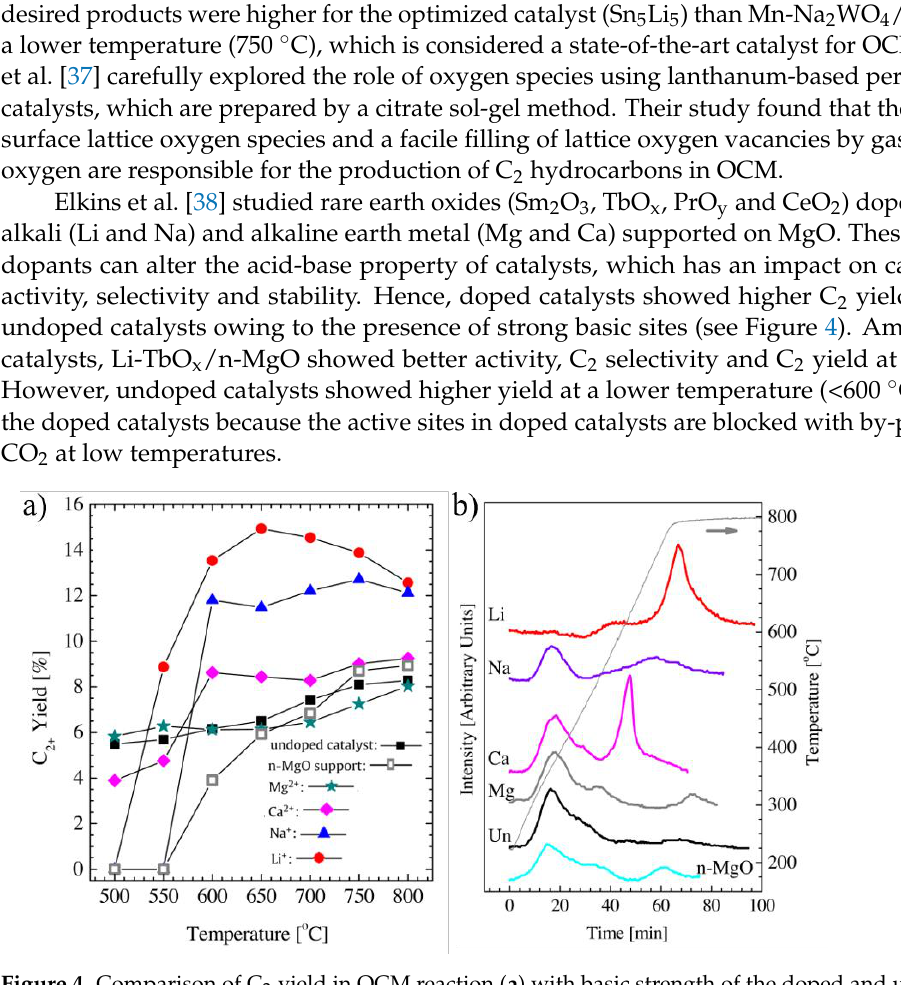
Figure 4. Comparison of C 2 yield in OCM reaction ( a ) with basic strength of the doped and undoped TbOx/n-MgO catalysts ( b ). Redrawn from [38] . Copyright 2018 Elsevier.